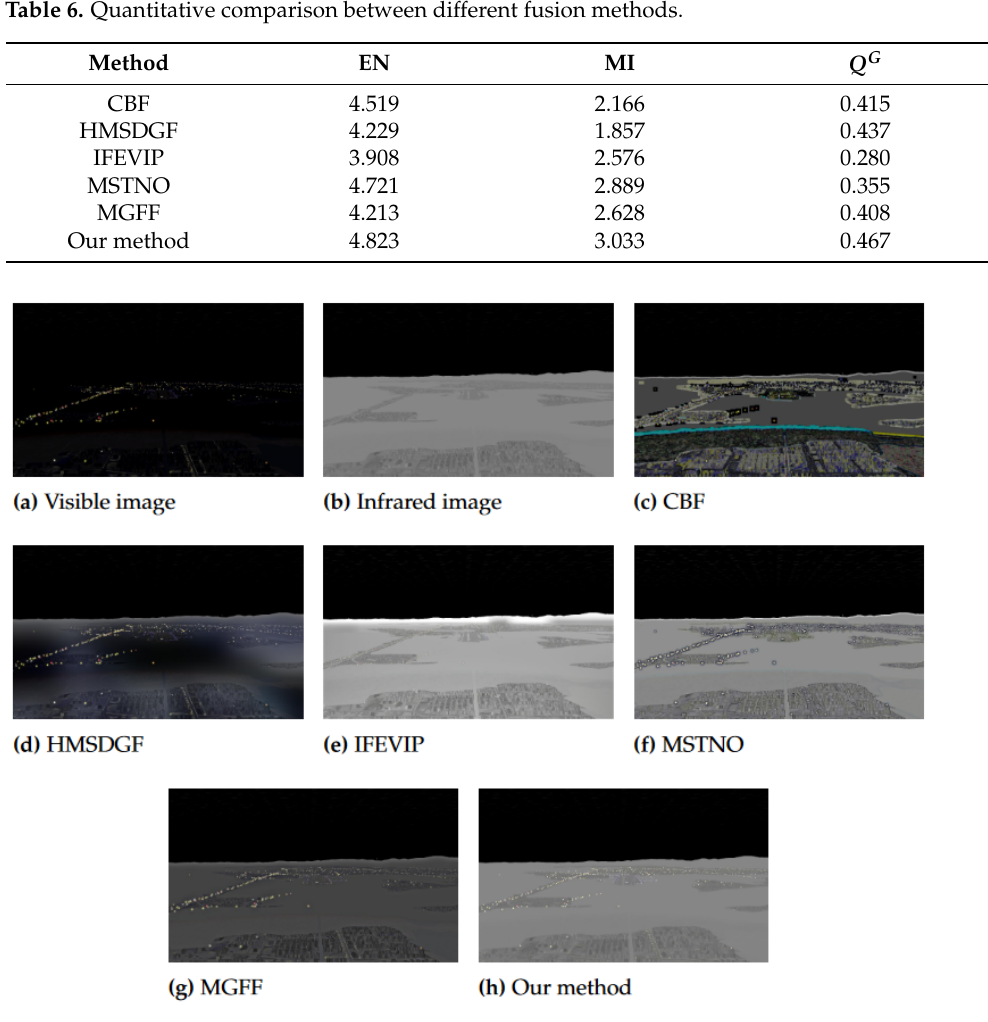
Figure 25. Visual comparison between different fusion methods of